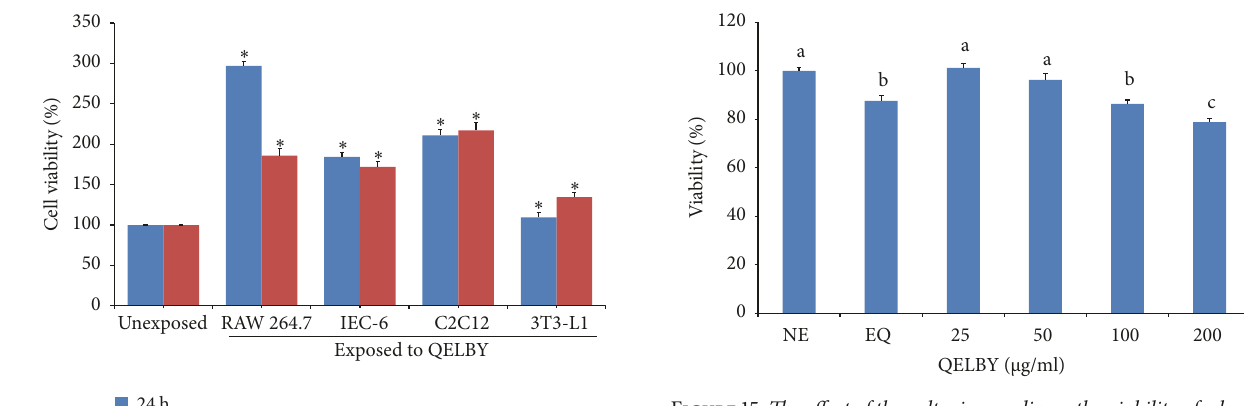
Figure 15: The effect of the culturing media on the viability of a breast cancer cell, MCF-7. NE in the diagram indicates that unexposed deionized water was used to prepare the medium as a control. EQ means that deionized water treated in the noncontact manner for 48 hours was used for the preparation of medium. The number indicates the amount of the suspended layer which was taken from the premixed DMEM with 1% of QELBY (cid:2) ceramic powder and left for 48 hours to prepare the media. Data are mean ± SD (𝑛 = 6) . Means with different superscript are significantly different at 𝑝 < 0.05 .